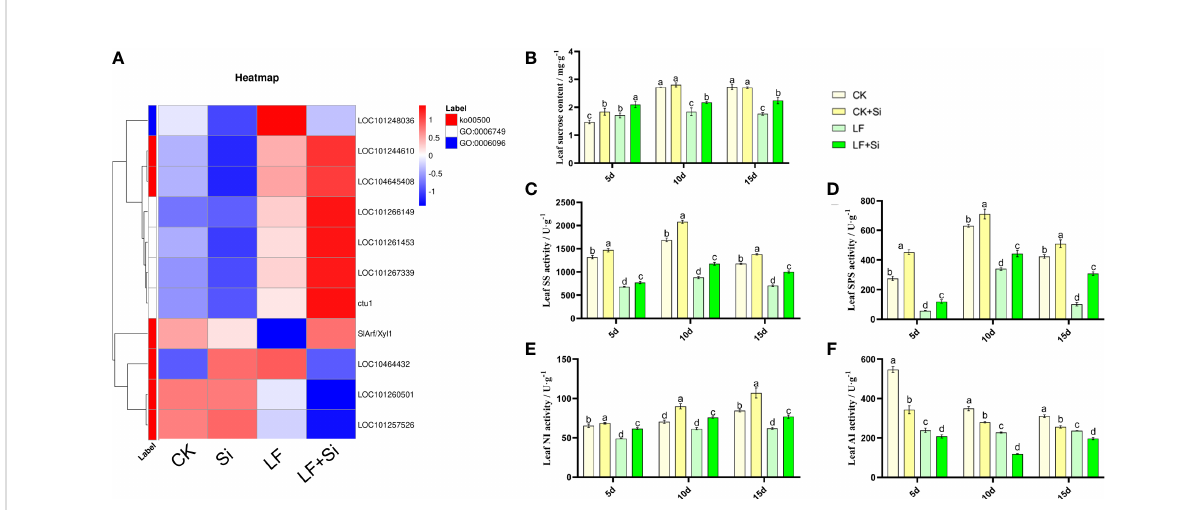
FIGURE 7 Response of sucrose metabolism of tomato leaves to silicon application under Fe de fi ciency. (A) Heat map of related differentially expressed genes. (B) Leaf sucrose content. (C) Leaf SS activity. (D) Leaf SPS activity. (E) Leaf NI activity. (F) Leaf AI activity. Each data point represents the mean of three independent biological replicates (mean ± SD). Different letters above the bars indicate statistically signi fi cant differences ( P